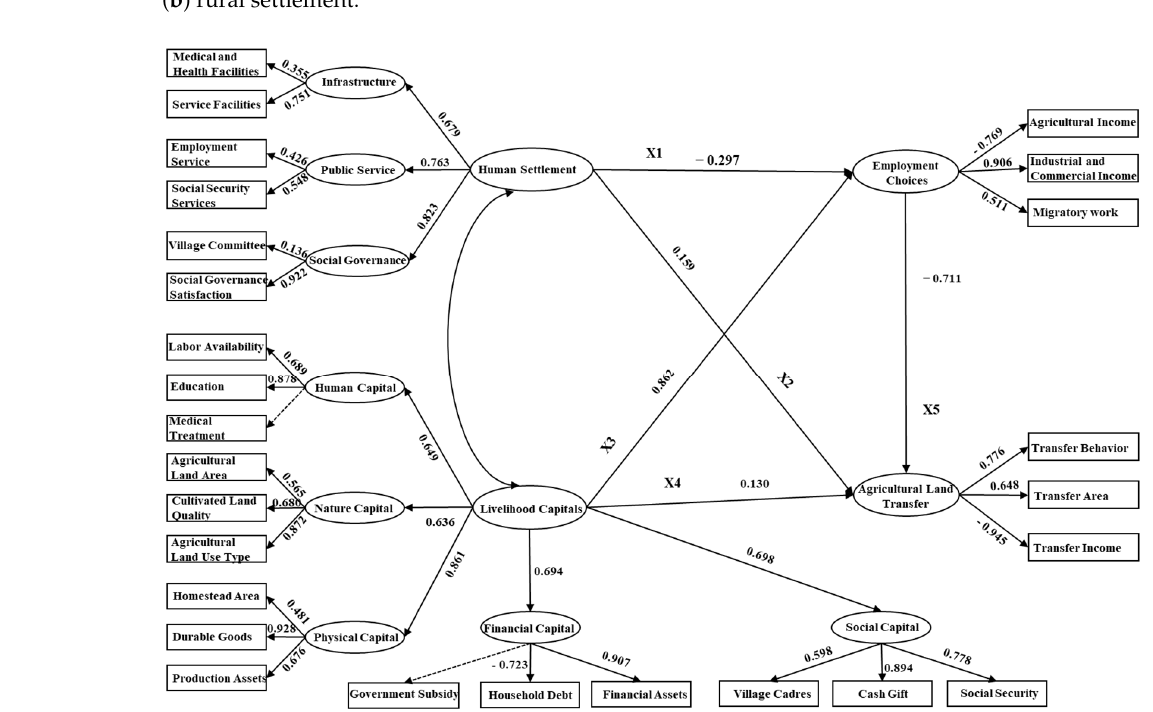
Figure 4. Descriptive statistics for the explanatory variables by region: ( a ) household livelihood; ( b ) rural settlement.